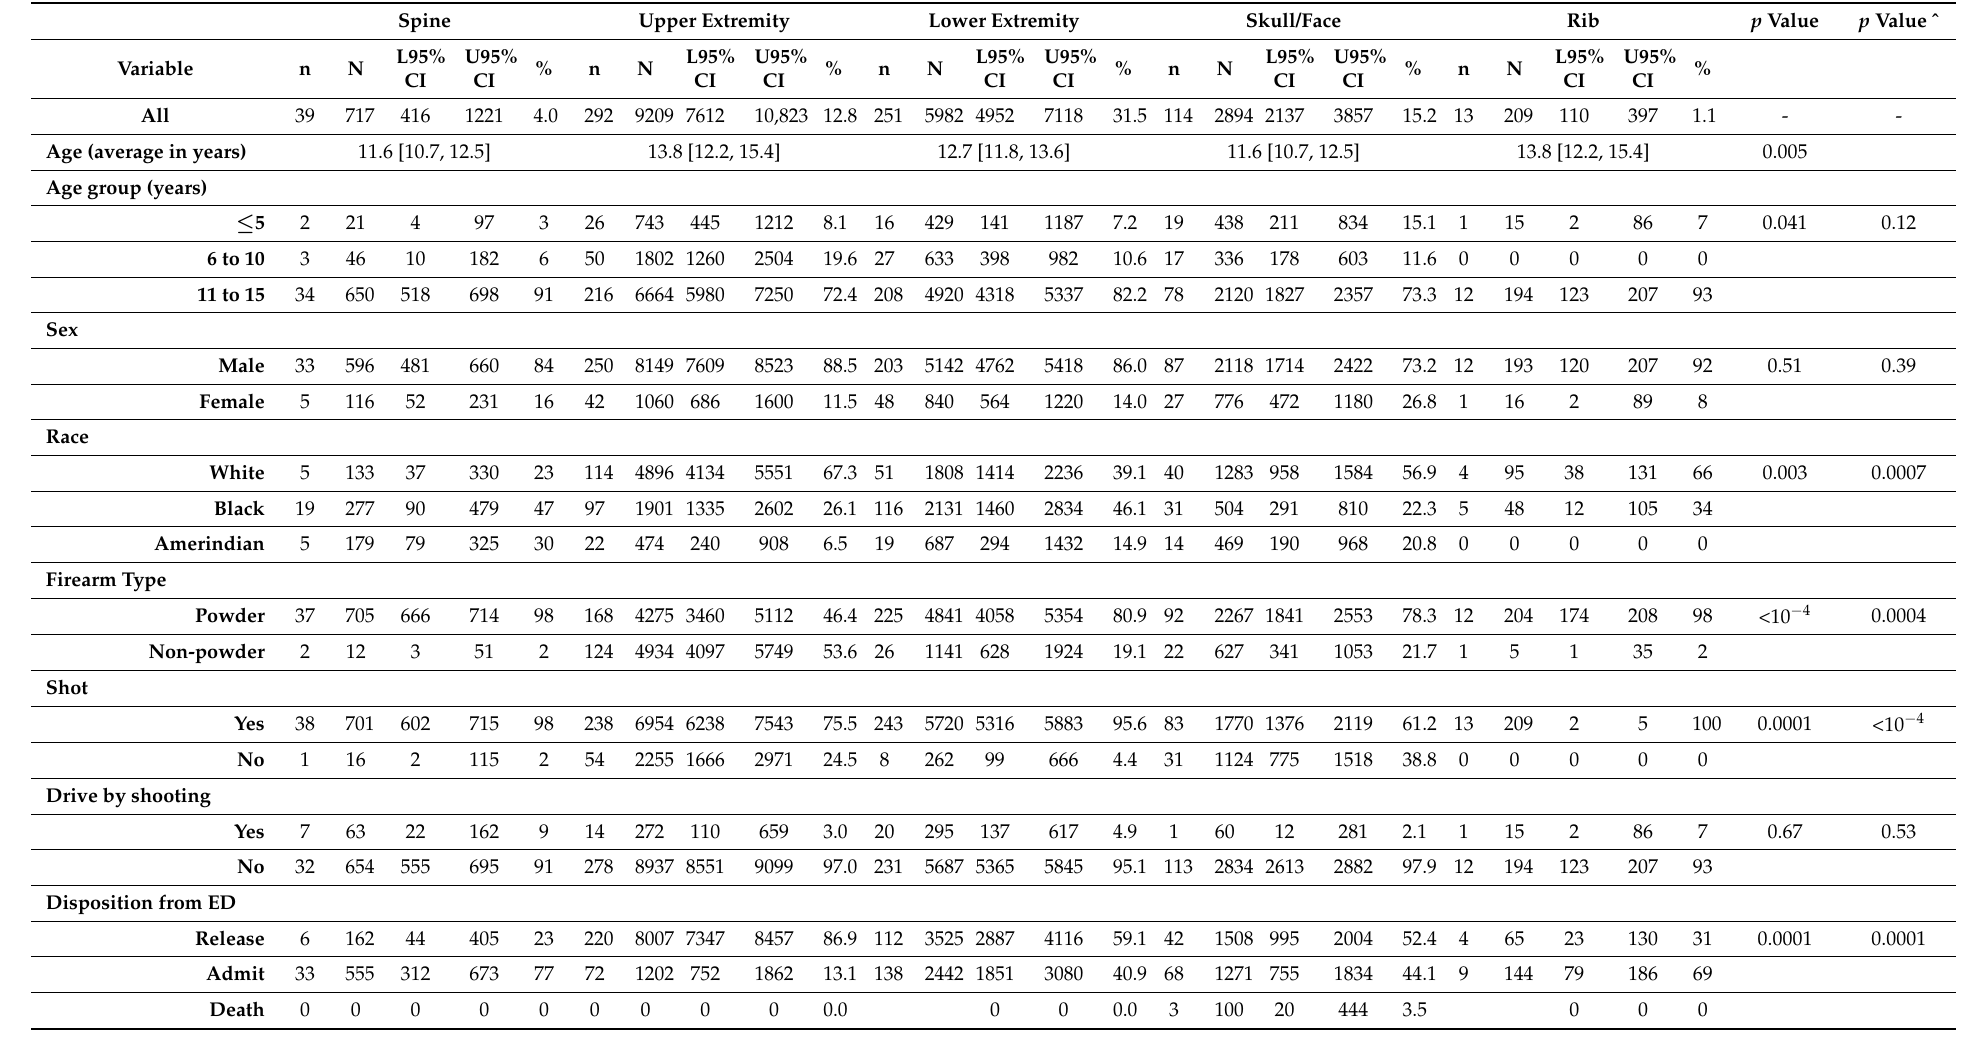
Table 3. Analyses by fracture